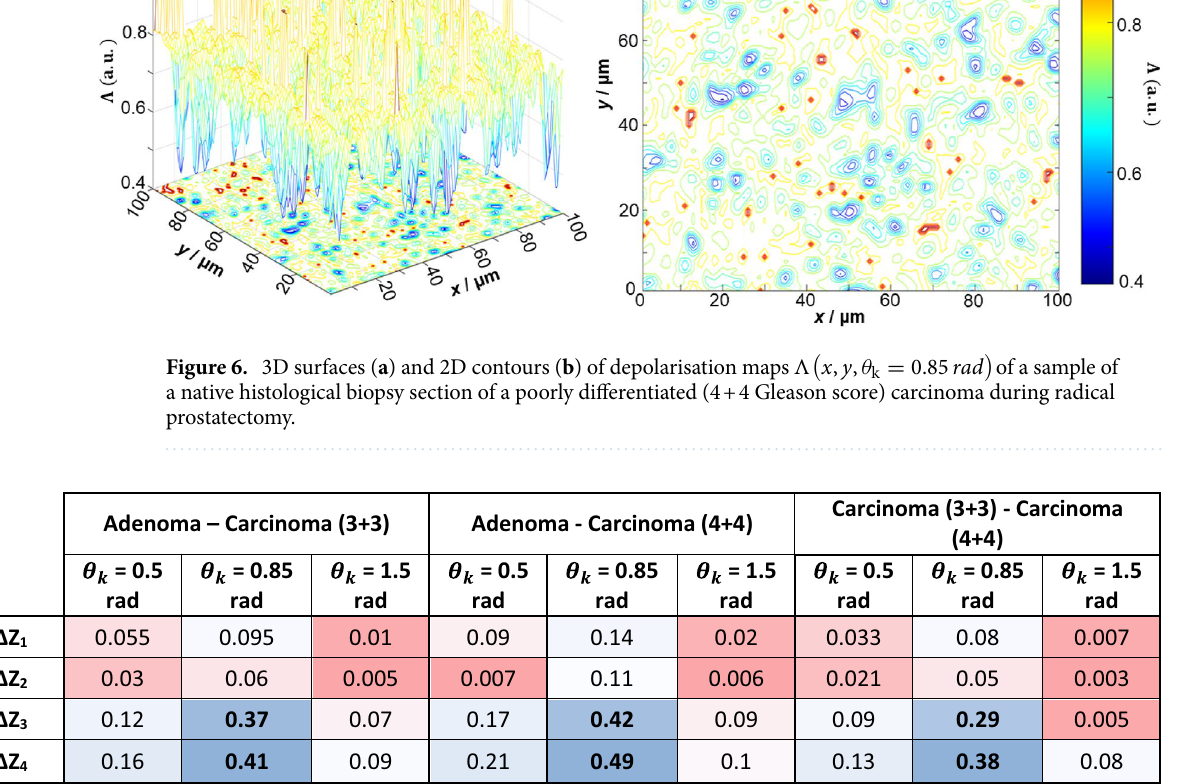
Table 2. Intergroup differences in the magnitude of the central statistical moments of the 1st–4th orders (cid:31) Z i = 1 ; 2 ; 3 ; 4 , which characterize the distributions of the magnitude of the degree of depolarisation � the layered phase sections corresponding to θ k = 0.5rad , θ k = 0.85rad , and θ k = 1.5rad .